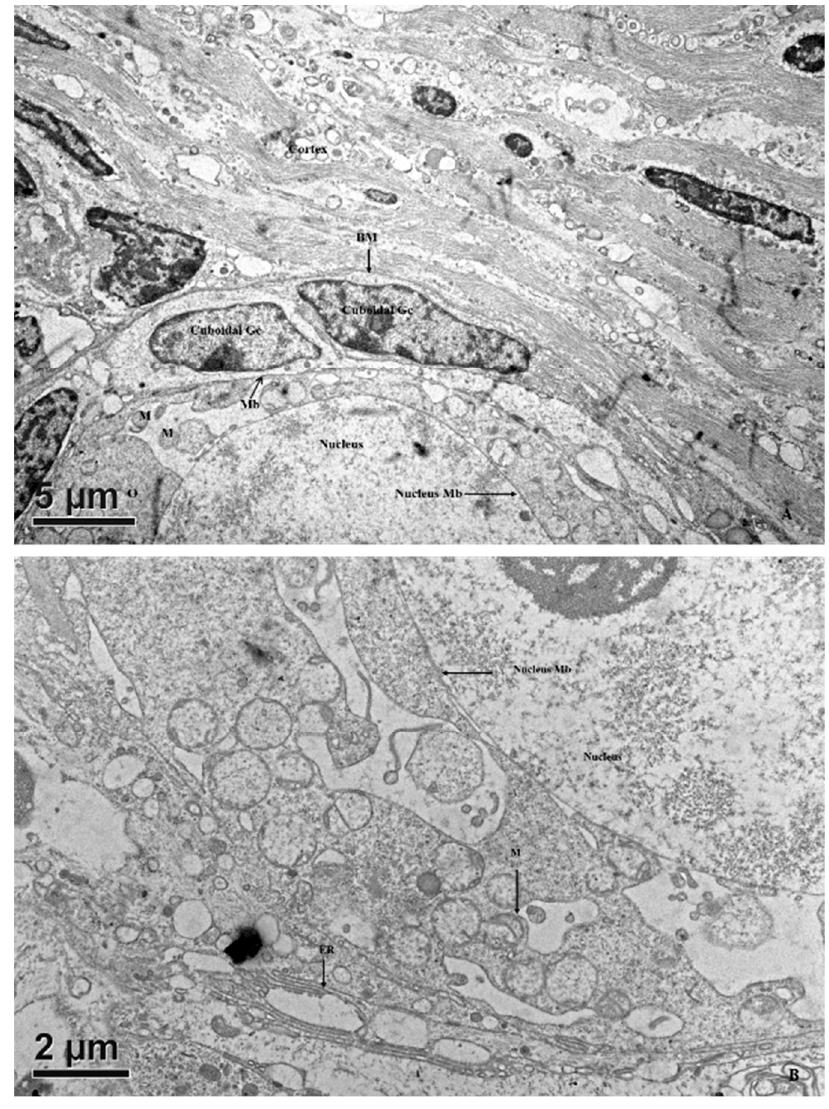
Figure 3 . Transmission electron microscopic images showing the ultrastructure of oocytes and their surrounding cells in porcine primary follicles. ( A ) An early primary follicle with one layer of cuboidal granulosa cells beneath the basement membrane (BM) possessing an eccentric nucleus and clusters of organelles. ( B ) Note the clustering of organelles consists of mitochondria, endoplasmic reticulum, and vesicles, which are all tightened by the cement-like structure. The primary follicle has an even distribution of organelles throughout the ooplasm. Granulosa cells (GCs) are cuboidal in shape and oocyte cytoplasm contains mitochondria (M). ER, endoplasmic reticulum; O, oocyte; N, nucleus; M, mitochondrion; Mb, membrane.